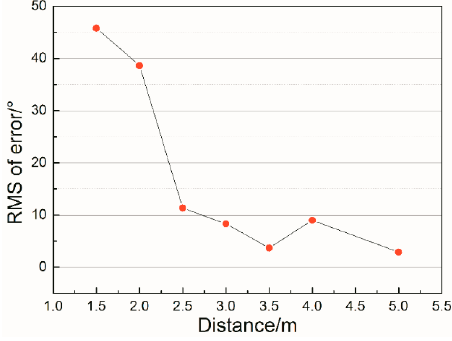
Figure 11. Relationship between error and detection distance.